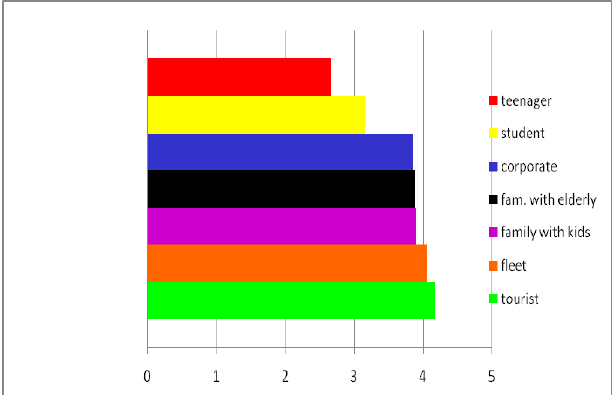
Figure 17. Importance of future LBS applications for various user classes, as perceived by the respondents, on a scale of 1 (not important) to 5 (very